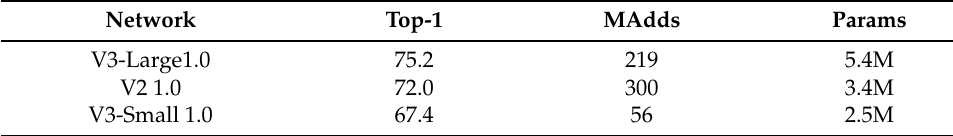
Table 12. MobileNet v2, v3 in ImageNet.